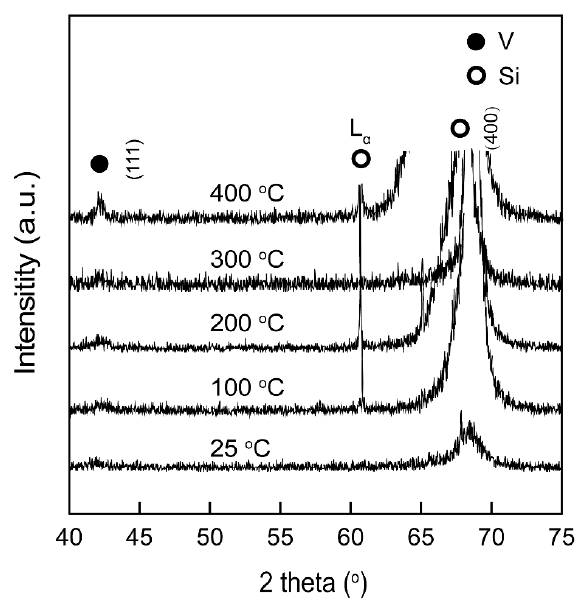
Figure 1. XRD patterns of V films deposited on Si (100) at D t-s = 60 mm with different T s .